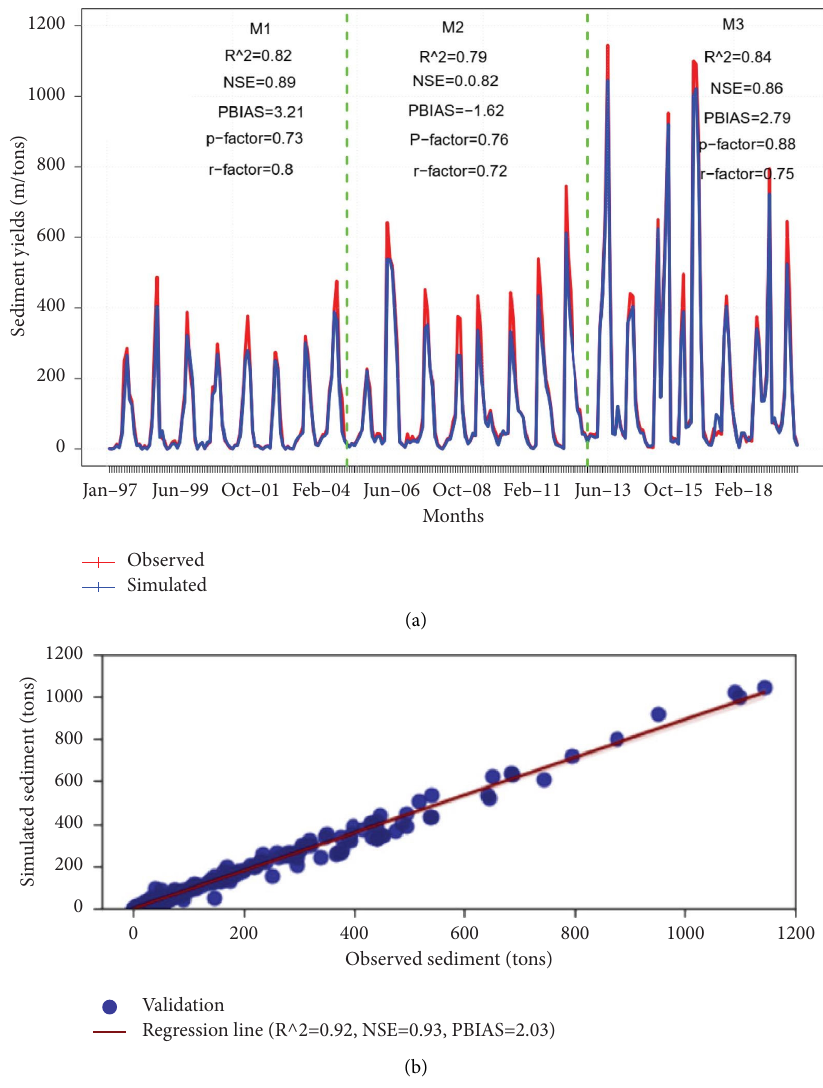
Figure 8: Calibration (a) and validation (b) of sediment yields for three